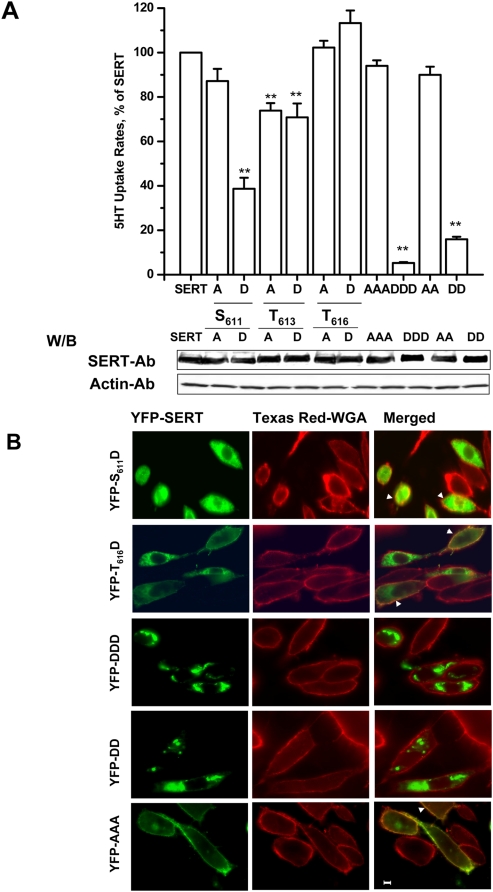

(A) 5HT uptake rates of SITPET mutants.Twenty-four hour post-transfection CHO cells were washed and assayed for analysis of 5HT uptake rate. Background accumulation of (3H)-serotonin was measured in the same experiment using mock-transfected cells and subtracted from each experimental value. Maximum background accumulation was 0.01 pmol/mg protein/min. Phospho-mimicking mutations in the C-terminal region caused mixed results. The S611D mutation resulted in the most significant change over its neutral counterpart, S611A. Another key point is the drastic reduction seen when all 3 sites were mutated to aspartic acid and when only the two threonines were mutated to aspartic acid. Bars represent means±SD of three or more independent experiments. ANOVA indicated that the effect of the construct was highly significant (p<0.001). Multiple post-hoc comparisons versus control (SERT) were made applying Dunnett's correction; values marked with (**) were significantly different from control at p<0.05. Expression of SITPET mutants. The trafficking of mutants was assessed by gel electrophoresis and W/B. The detergent extracts of total protein were analyzed to determine if the alteration in uptake ability was due to alterations in the amount of protein. All variations of the transporter demonstrated similar protein expression levels. All lanes contain protein recovered from the same number of cells equivalent to 30% of one well from a confluent 24 well dish. The loading control was performed with actin (inset in the figure). The immunoblots are representative of at least three independently performed experiments. (B) Colocalization of YFP-SERT mutants on the plasma membrane. Cells were stained with Texas Red-WGA to mark the plasma membrane. The images show that DD and DDD mutations were totally retained on intracellular structures; S611D was found partially on the intracellular compartments. However, AAA and T613D were predominantly on the plasma membrane (arrowheads), but a pool of them resided on intracellular organelles. A 1 μm bar is presented for the image set.